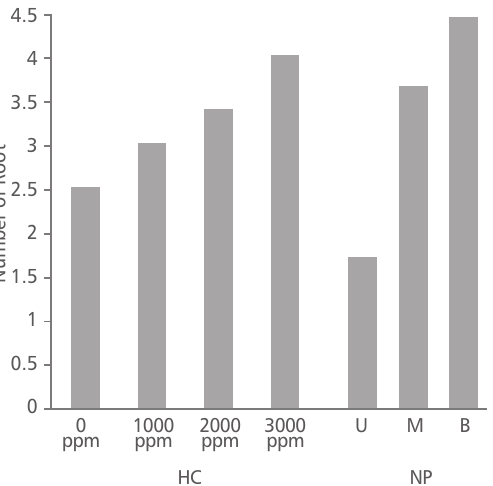
FIGURE 2. Number of root produced in D. tri- petala cuttings using different IBA hormone concentrations (HC) and nodal positions (NP) (U = upper node, M = middle node and B = basal